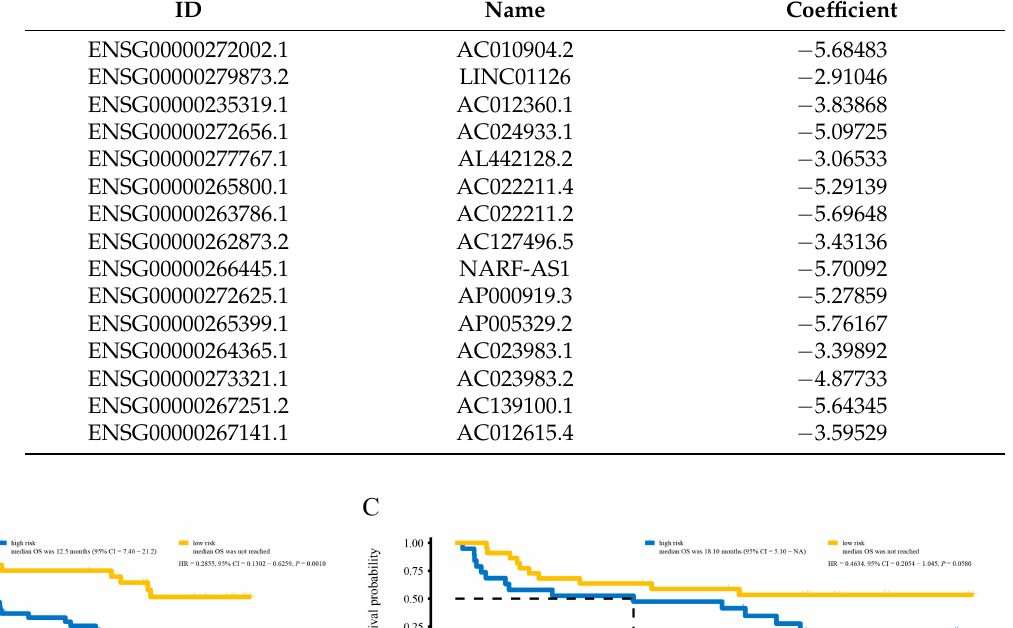
Table 2. Details of 15 lncRNAs signature.